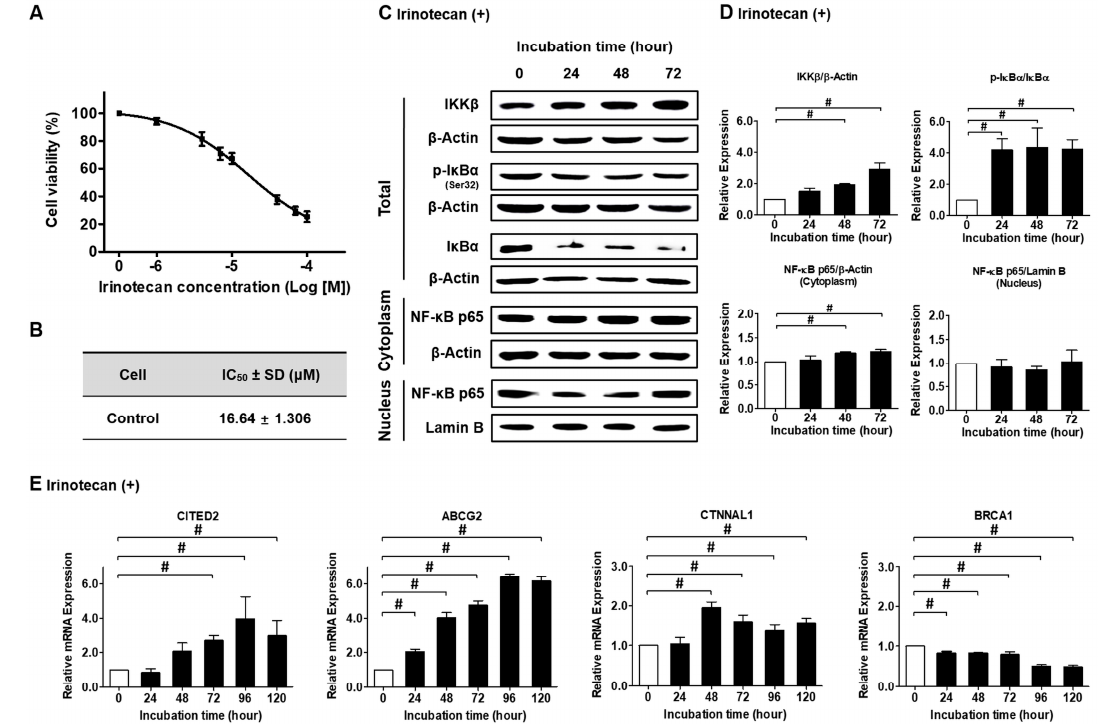
Figure 2. IC 50 of irinotecan in NSCLC cells (H1299) and its effects on NF- κ B signaling and drug resistance markers. ( A ) When cells were treated with 0–100 μ M of irinotecan, the viability (%) decreased in an irinotecan concentration-dependent manner. ( B ) IC 50 of irinotecan was 16.64 μ M. ( C ) Western blots of IKK β , p-I κ B α , I κ B α , and NF- κ B p65 after treatment with 17 μ M irinotecan. ( D ) Relative protein expressions of IKK β , p-I κ B α /I κ B α , and NF- κ B p65 (cytoplasm and nucleus) compared with those before treatment (1.0 fold). ( E ) Changes in drug resistance ( CITED2 , ABCG2 , and CTNNAL1 ) and sensitivity ( BRCA1 ) after irinotecan treatment. # significant difference at each time point after irinotecan treatment ( p < 0.05).